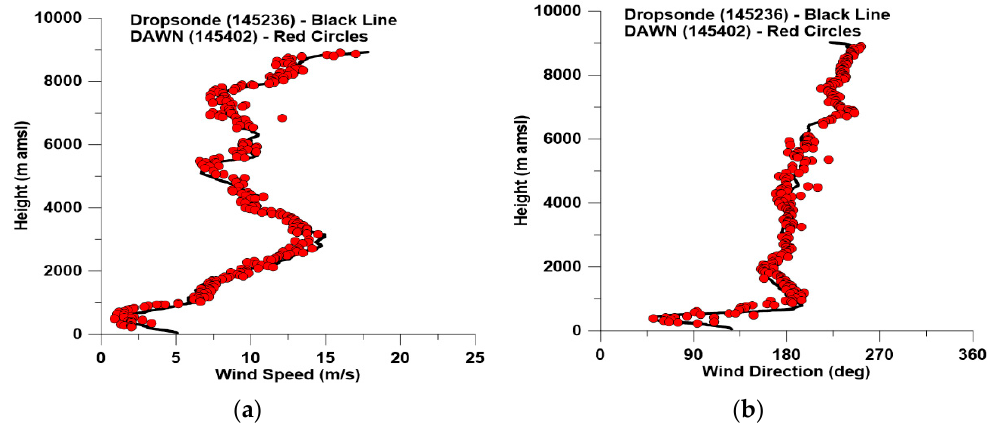
Figure 8. DAWN-dropsonde comparison of wind speed ( a ) and wind direction ( b ) for a convectively undisturbed and convective storm inflow case on 11 June 2017 ~185300Z.